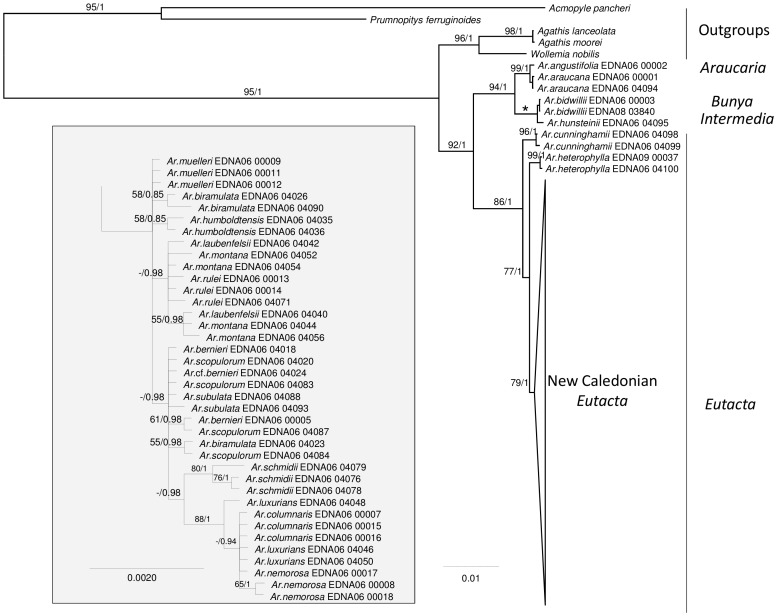
Araucariaceae phylogeny inferred from plastid DNA sequences using Bayesian optimisation criteria (50% majority rule topology).Support values, below the branch, are: ML bootstrap/Bayesian posterior probability. Branches marked with an asterisk have a BS of 100% and a PP of 1.0. Detail of the relationships among New Caledonian Araucaria is shown at the bottom left. Branch lengths are proportional to the inferred number of substitutions along that branch.